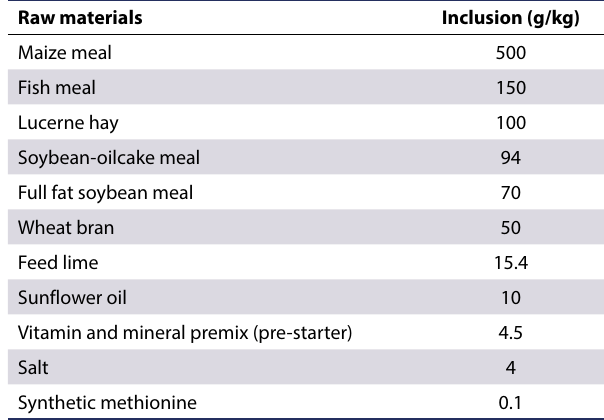
Table Ia: Composition of pre-starter diet (Brand 2005) fed to chicks during Trial 1